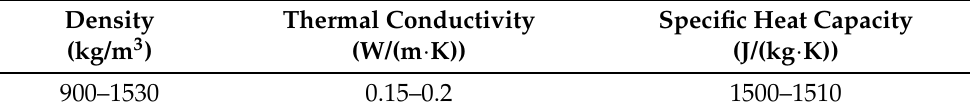
Table 1. Thermal properties of acrylonitrile butadiene styrene (ABS).